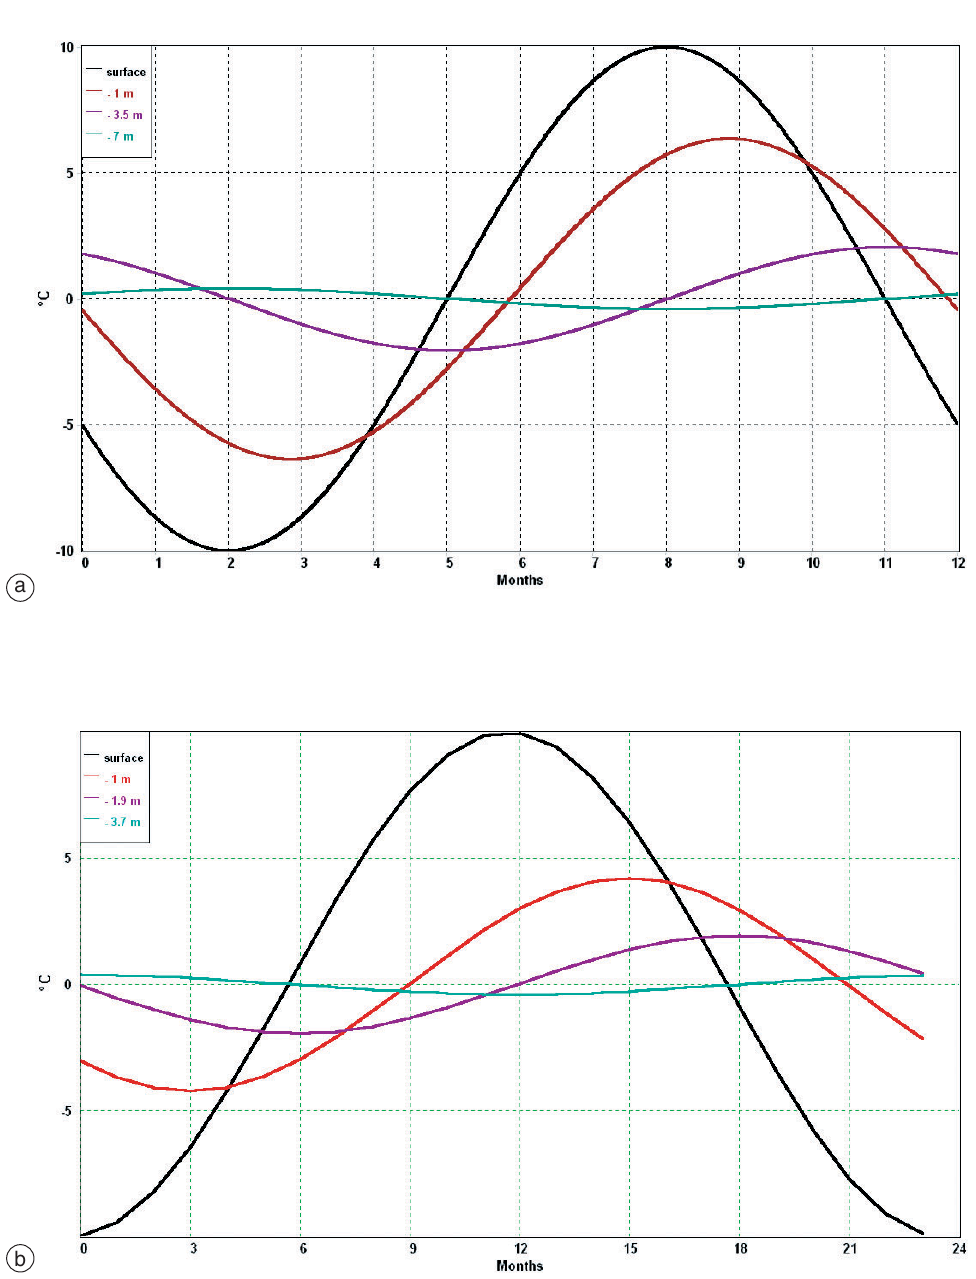
Fig. 7a,b. Theoretical thermic attenuation of an annual wave with parameters: a) D ≅ 0.0018 m 2 /h, α= 0.451 m − 1 , λ= 13.935 m, λ / T ≅ 0.038 m/d (the phase opposition occurs at a depth of 7 m); b) D ≅ 0.0018 m 2 /h, α= 8.614 m − 1 , λ= 0.729 m, λ / T ≅ 0.03 m/h (the phase opposition occurs at a depth of 0.37